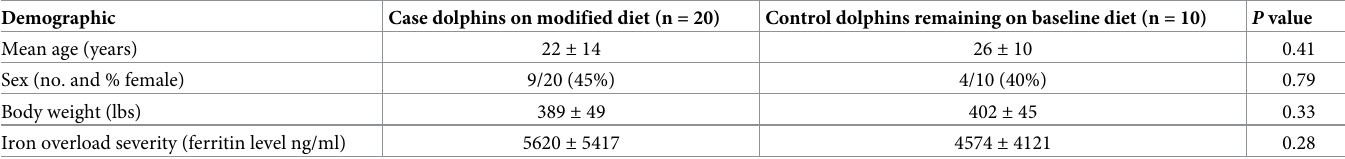
Table 1. Comparisons of demographics between feeding study case and control